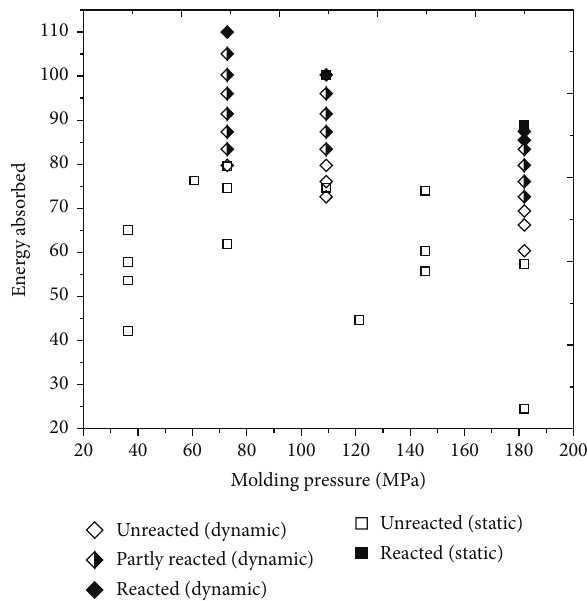
dynamic compression. For static compression, each unreacted point represents the result of a single sample; each reacted point means the lowest energy level needed to initiate. For dynamic compression, an unreacted point means no reaction has been observed at that energy level; a partly reacted point means reaction was observed for at least one sample; a reacted point means all samples were reacted at that energylevel.Noticethatatenergyof100 Jbothreactionsunderstatic compression and under dynamic compression took place, which made the point look like an eight-pointed star.